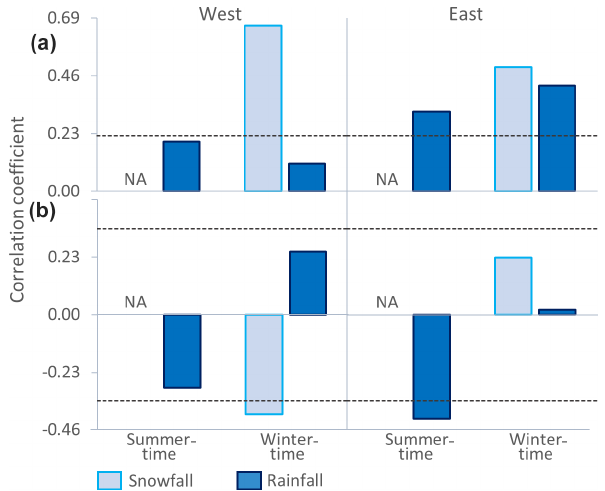
Figure 6. Interannual correlations between the series of the number of days with G-CHs per season and (a) precipitation and (b) mean temperature. Dashed lines indicate significance at 95%